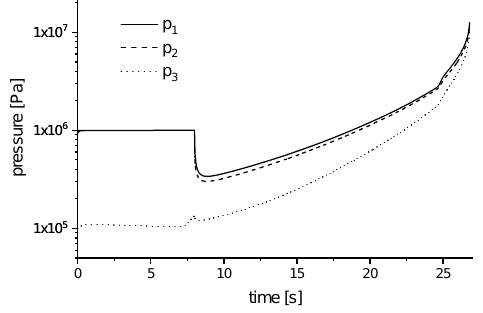
Figure 12. Cavity pressure development for sensors p 1 , p 2 and p 3 of the complex part.